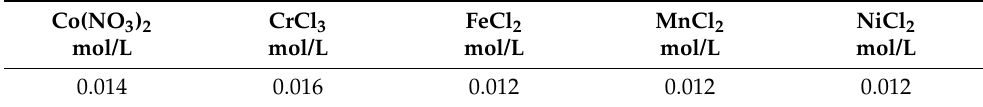
Table 1. Chemical composition of the